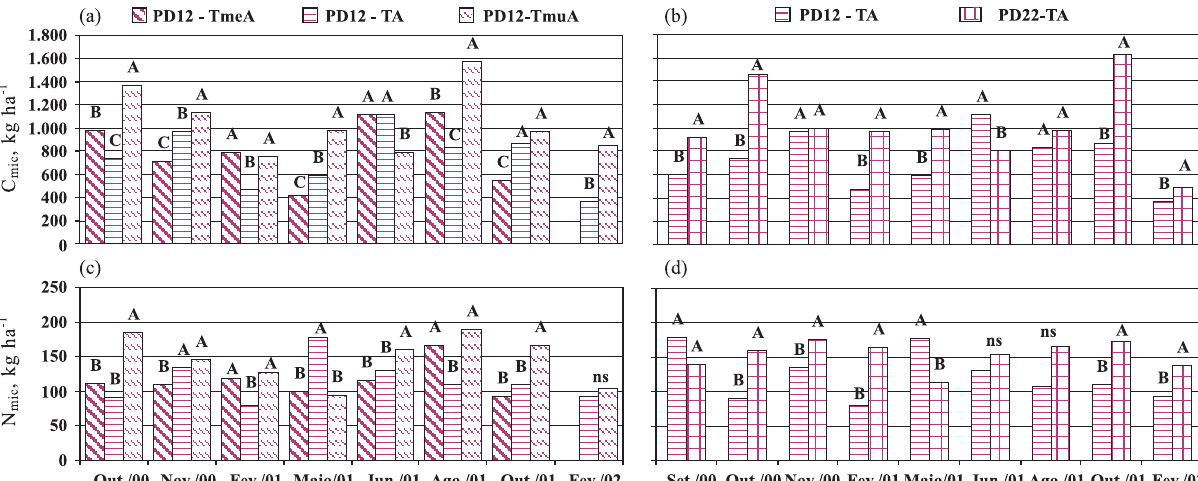
Figura 3. Teores de C e N em solos de diferentes classes texturais (a e c) sob 12 (PD12) e 22 (PD22) anos de adoção de sistema plantio direto (b e c) na camada de 0–20 cm. TA: solo com textura argilosa; TmuA: solo com textura muito argilosa; TmeA: solo com textura média argilosa. Médias seguidas de mesma letra não diferem estatisticamente entre si pelo teste de Tukey a 5 %. ns: análise de variância não-significativa pelo teste F a 5